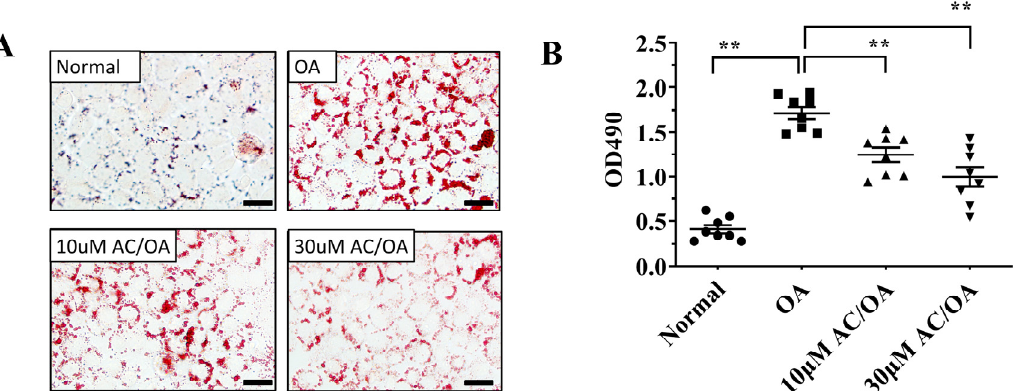
Figure 9. Acacetin (AC) attenuated lipid accumulation in FL83B cells. ( A ) Oil Red O staining re- vealed lipid accumulation (200× magnification). ( B ) FL83B cells treated with isopropanol and lipid accumulation was measured using the absorbance at OD 490 nm. Values are presented as mean ± SEM. * p < 0.05, ** p < 0.01 indicate significant differences compared to FL83B cells treated with oleic acid (OA). (scale bar = 100 µm).